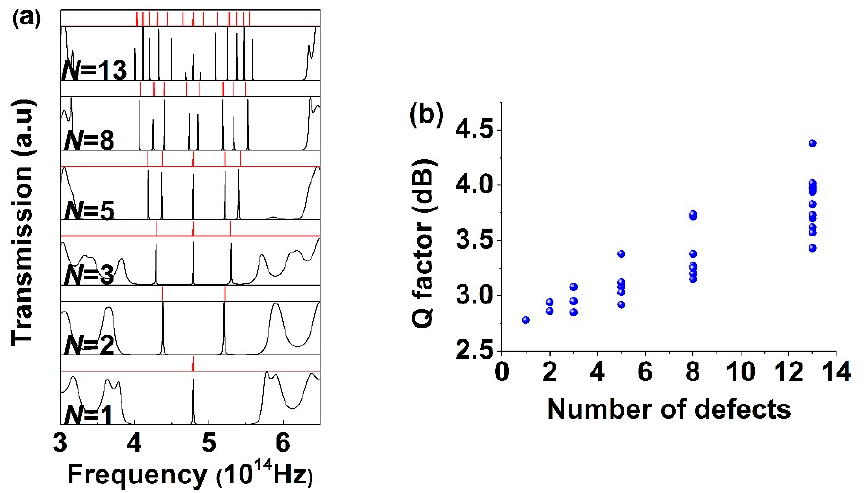
Figure 2. ( a ) Comparison of resonant frequencies of the Fibonacci-spaced defect resonators obtained from the theoretical model developed (the red line) and the simulation using FDTD (the black line) with different generation order for κ S = 0.42, κ L = 0.27. The results agree well, and the discrepancies are expected to vanish if the first and last coupling coefficients are modified due to external losses. ( b ) Q factor increases exponentially with mode splitting.